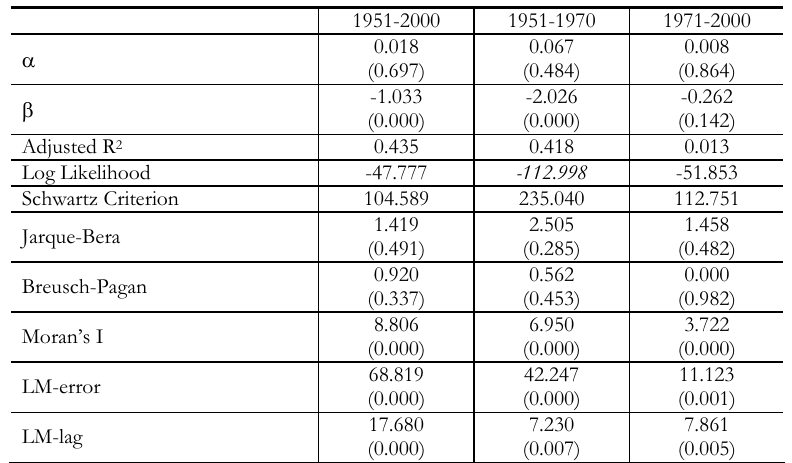
Per Capita Income Growth of Italian Provinces OLS Estimates (numbers into brackets refer to the p-values) 1951-2000 1951-1970